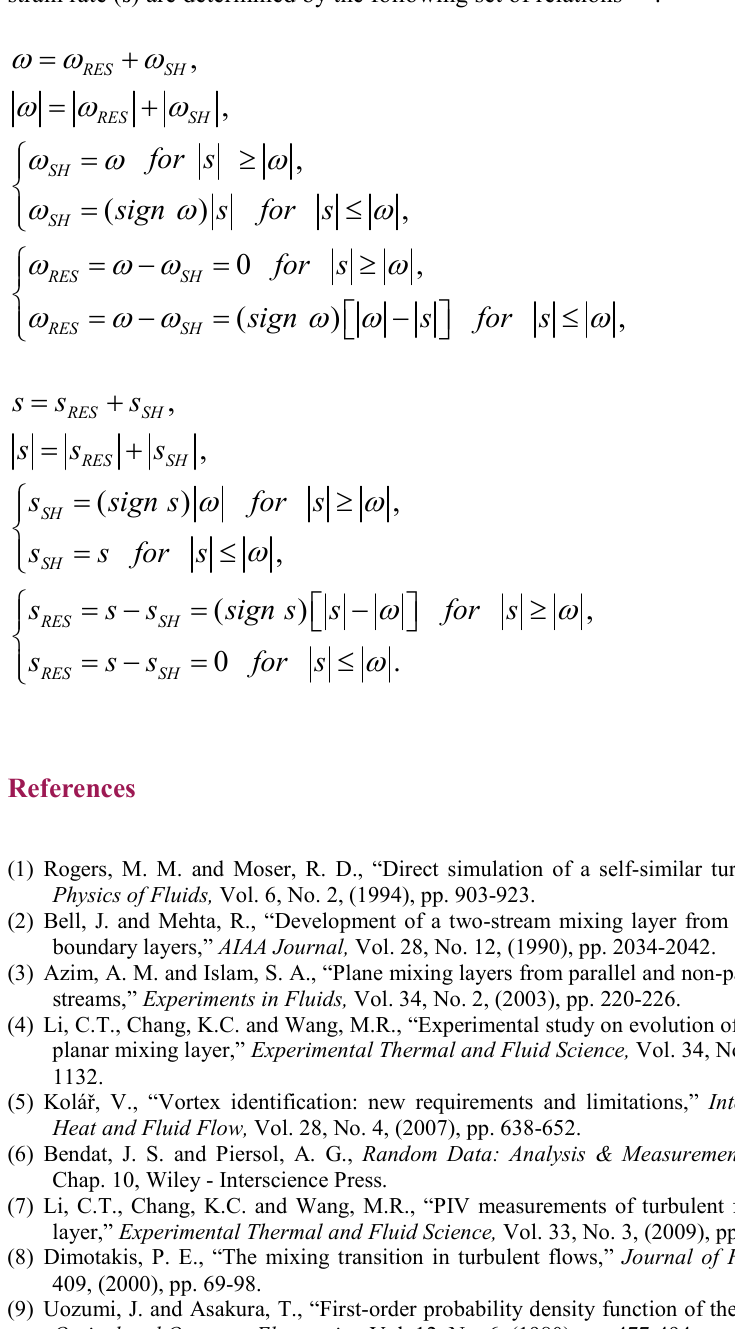
The residual and shear components of the instantaneous vorticity ( ω ) and instantaneous strain rate ( s ) are determined by the following set of relations (5)